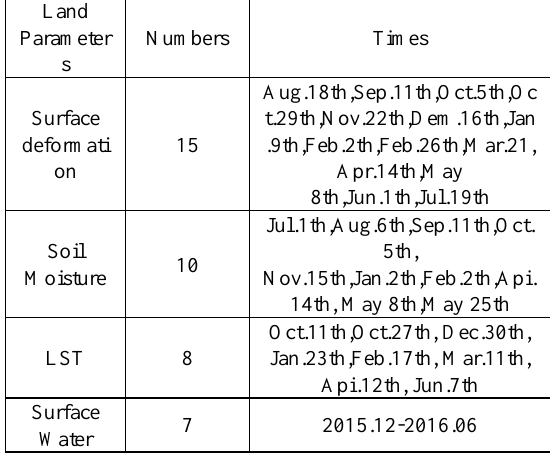
Table 1. The information of the data used in this paper